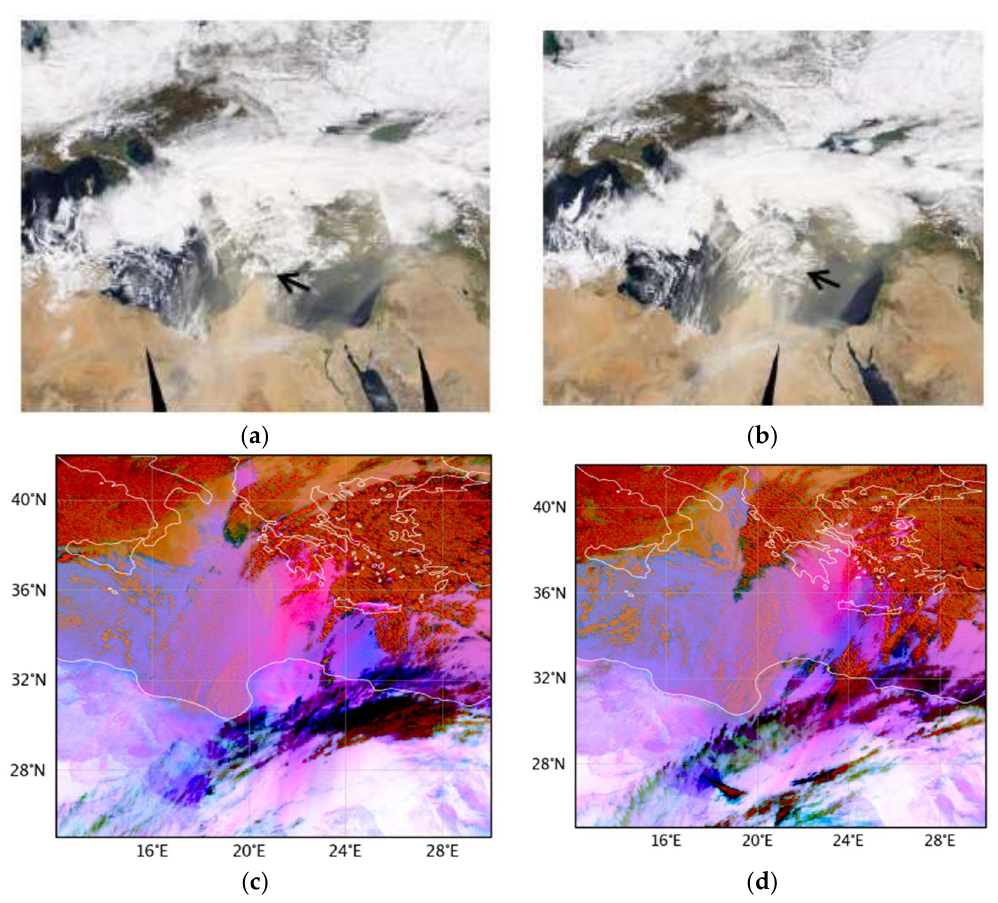
Figure 1. Up ( a , b ) True color images from MODIS-Terra (left) and MODIS-Aqua (right) on 22 March 2018. The arrows indicate the location of Crete; Down ( c , d ) MSG-SEVIRI dust RGB images on 1200 UTC (left) and 1500 UTC (right), 22 March 2018.